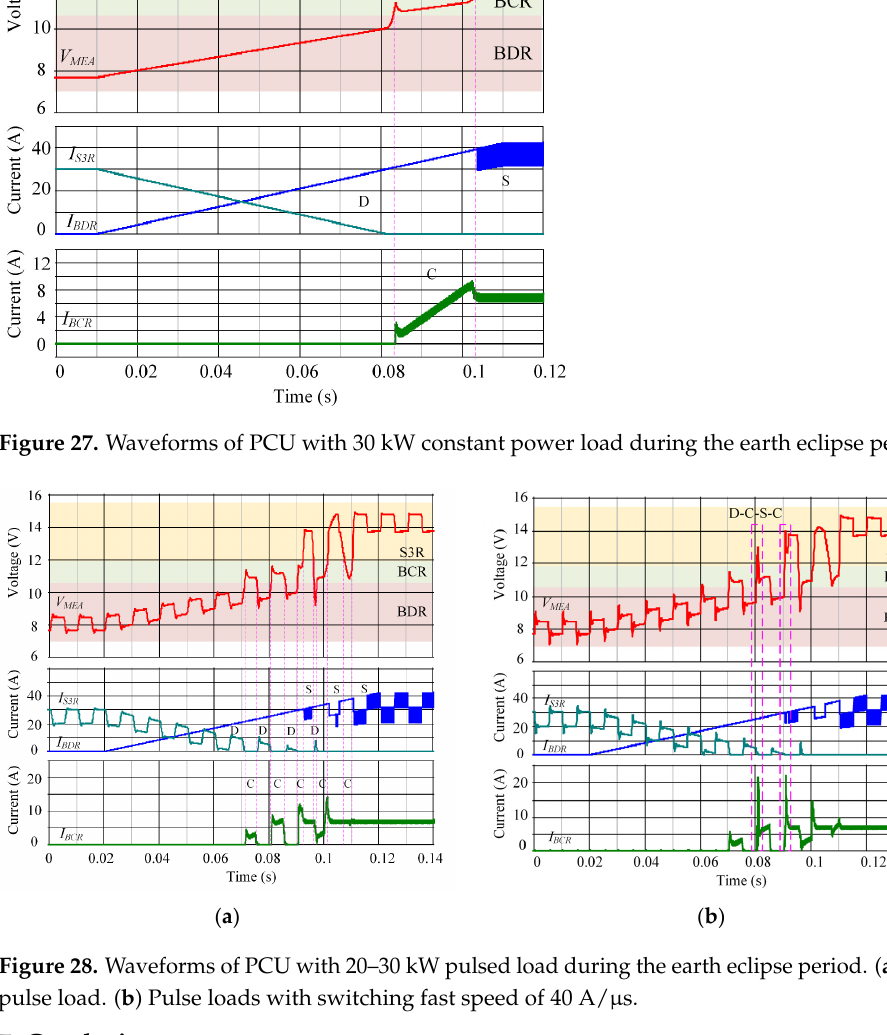
Electronics 2022 , 11 , x FOR PEER REVIEW